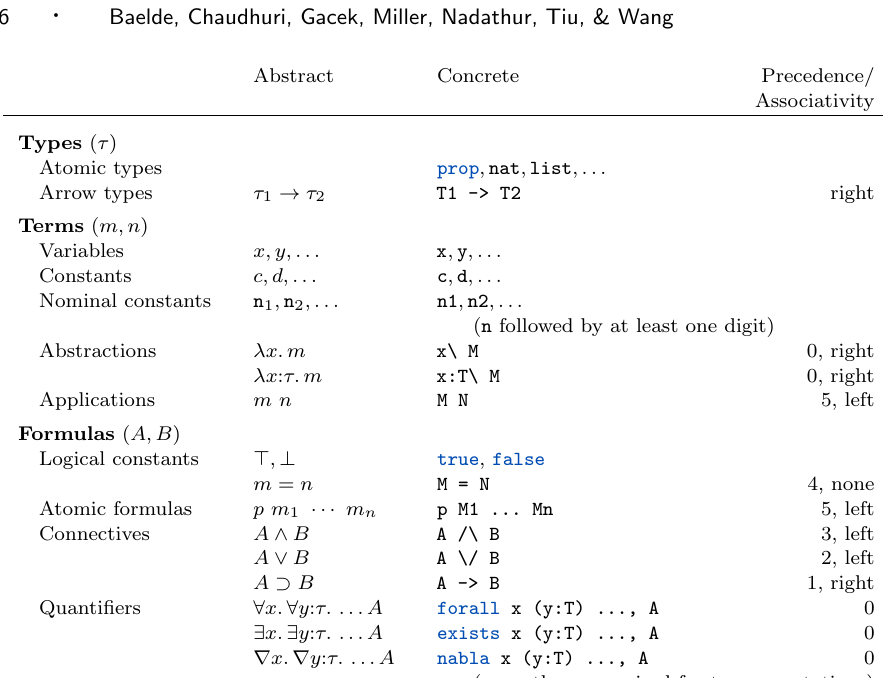
Fig. 1: Concrete Syntax for G in